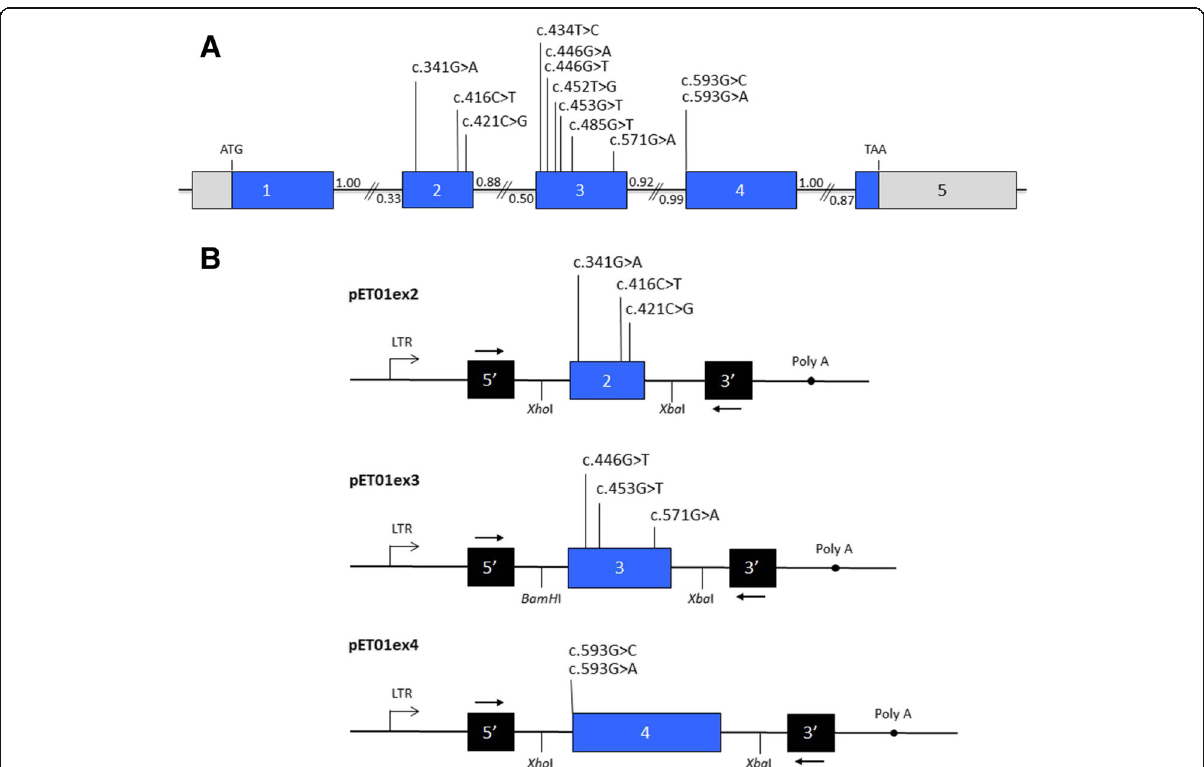
Fig. 2 Location of presume missense mutations analysed in this study and schematic representation of CLDN16 minigenes. a Boxes represent the five coding exons and black lines in between indicate intron sequences. Coding and non-coding regions appears in blue and grey, respectively. Exons and introns sizes are not at scale. Small numbers indicate NNSplice scores of donor and acceptor splice sites. b Structure of CLDN16 minigenes used in the splicing reporter assay. Blue and black boxes represent CLDN16 exons and 5 ′ and 3 ′ exons of the shuttle vector pET01, respectively. Black lines indicate intron sequences. The minigenes were constructed by introducing a CLDN16 genomic fragment containing exons 2, 3 or 4 and flanking intronic sequences into the vector as described in Materials and Methods. The position of each mutation and the restriction sites used for cloning are indicated. Arrows above and below the vector exons represent primers used in the RT-PCR assays. LTR, long terminal repeat promoter of the Rous sarcoma virus; Poly A, polyadenylation site. The minigenes will express a poly-A+ RNA containing the spliced